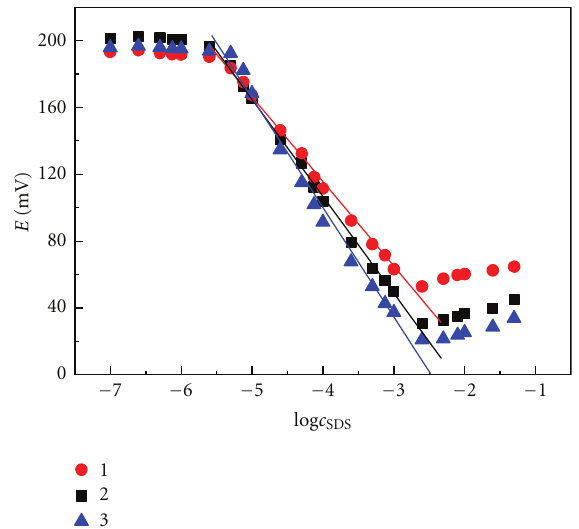
Figure 3: E ff ect of pH on the potentials of anionic surfactant Figure 1: Potential response of the surfactant-selective electrode 10 (cid:2) 4 and 1 10 (cid:2) 3 molL (cid:2) 1 SDS solution. selective electrode in 1 with di ff erent composition to SDS. Ingredients (wt%): : DOP (cid:3) (cid:3) (cid:4) : DOP (60%), PVC (33%), ion (60%), PVC (34%), ion pair (1%), (cid:5) pair (2%), : DOP (60%), PVC (32%), ion pair (3%). (cid:6)